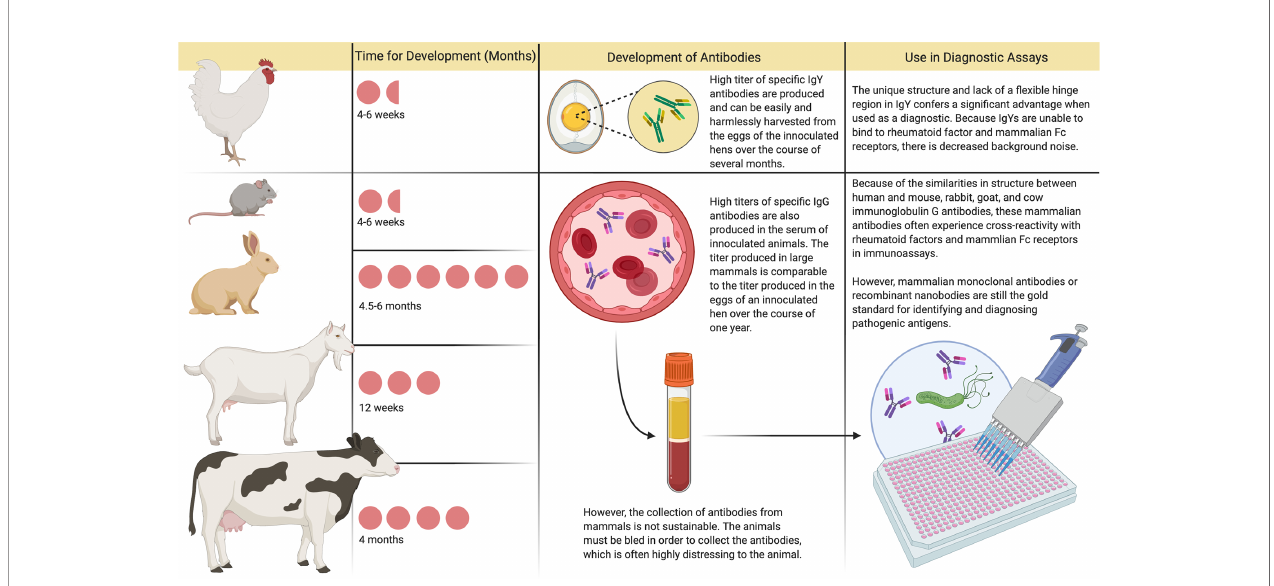
FIGURE 2 | Immunoglobulin Y and Immunoglobulin G Antibody Development and Use in Diagnostic Assays. In animals raised for conventional antibody production, immunoglobulin G (IgG) is the main serum antibody collected. The amount of antibody that can be harvested from the blood in one setting is comparable to the amount of immunoglobulin Y (IgY) produced in the eggs of a commercial laying hen over a year. However, production of these conventional antibodies usually requires 2-6 months, and harvesting through bleeding is distressing to the animal. Currently, mammalian monoclonal antibodies are considered the gold standard for use in diagnostic assays, although they are prone to exhibit cross-reactivity and are costly to produce. In contrast, after inoculation with the desired antigen, hens produce speci fi c antibodies in their eggs within 4-6 weeks. These IgY antibodies can be easily harvested and used in diagnostic assays, with lower background and cross-reactivity compared with current industry